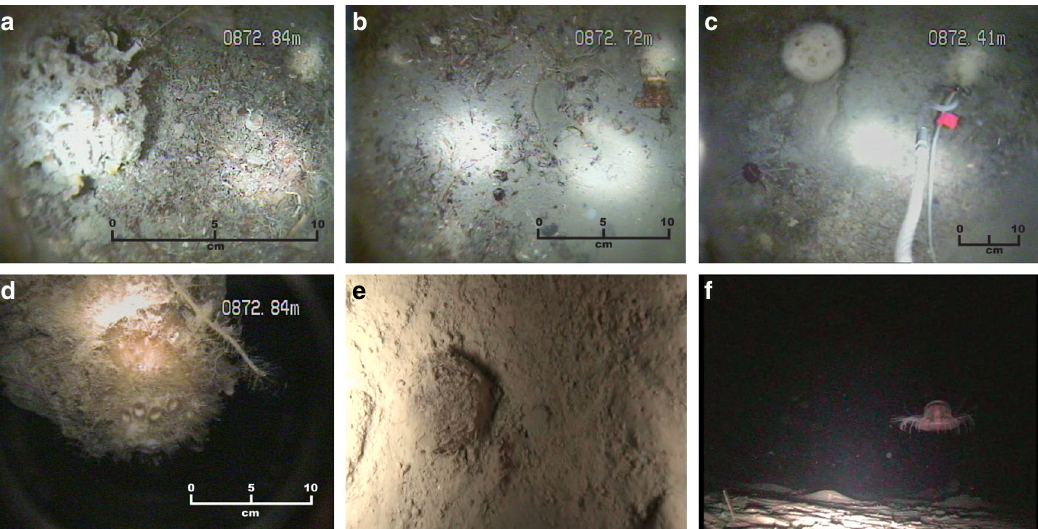
Fig. 3 Sea fl oor biota imaged beneath the Amery Ice Shelf illustrating variations in ocean current circulation beneath the ice shelf. a – d Diverse community dominated by sessile fi lter feeders at sites of in fl owing bottom currents, 100 km from the calving front. e Deposit-feeders 200 km from the calving front associated with in fl owing bottom currents. f Mobile scavengers imaged 160 km from the calving front in an area of weak bottom current circulation. For details of biota, see ref. 42 . Images © Martin Riddle/Australian Antarctic